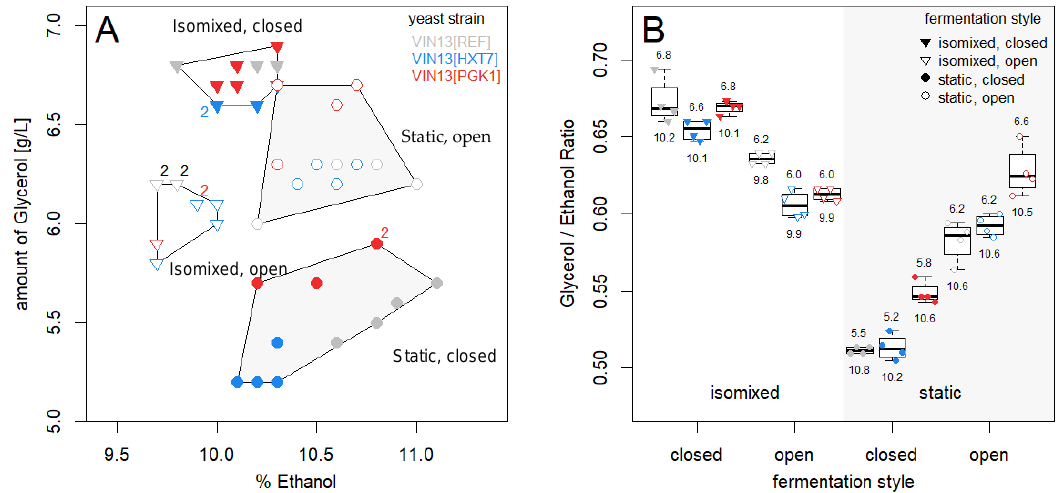
Figure 3. Relationship between the glycerol and ethanol levels in the wines produced under different fermentation styles. ( A ) Scatter plot with the percentage of ethanol plotted on the x -axis and the glycerol (in g / L) on the y -axis. Numbers indicate the presence and abundance of samples which showed similar amounts of both ethanol and glycerol, and hence, were plotted on top of one another. ( B ) is a box-and-whiskers plot showing the glycerol / ethanol ratio with the amount of glycerol [g / L] divided by ethanol content (%). For each VIN13 strain and fermentation condition, the average amount of glycerol [g / L] and ethanol content (%) are given above and below the box-and-whiskers plots, respectively. Colored points show the actual values obtained from each fermentation.